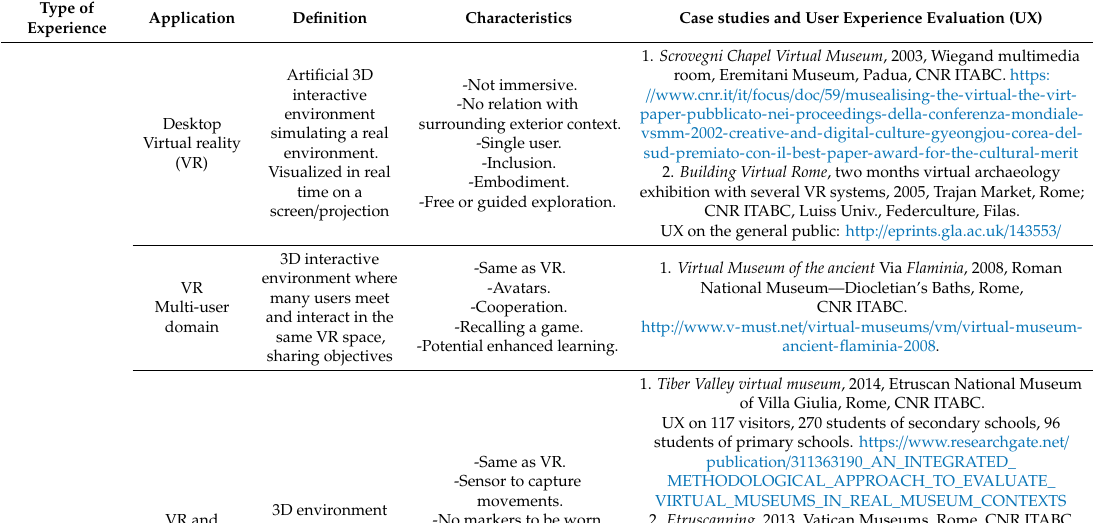
Table 1. The di ff erent types of experiences that will be discussed in the paper, their definitions and